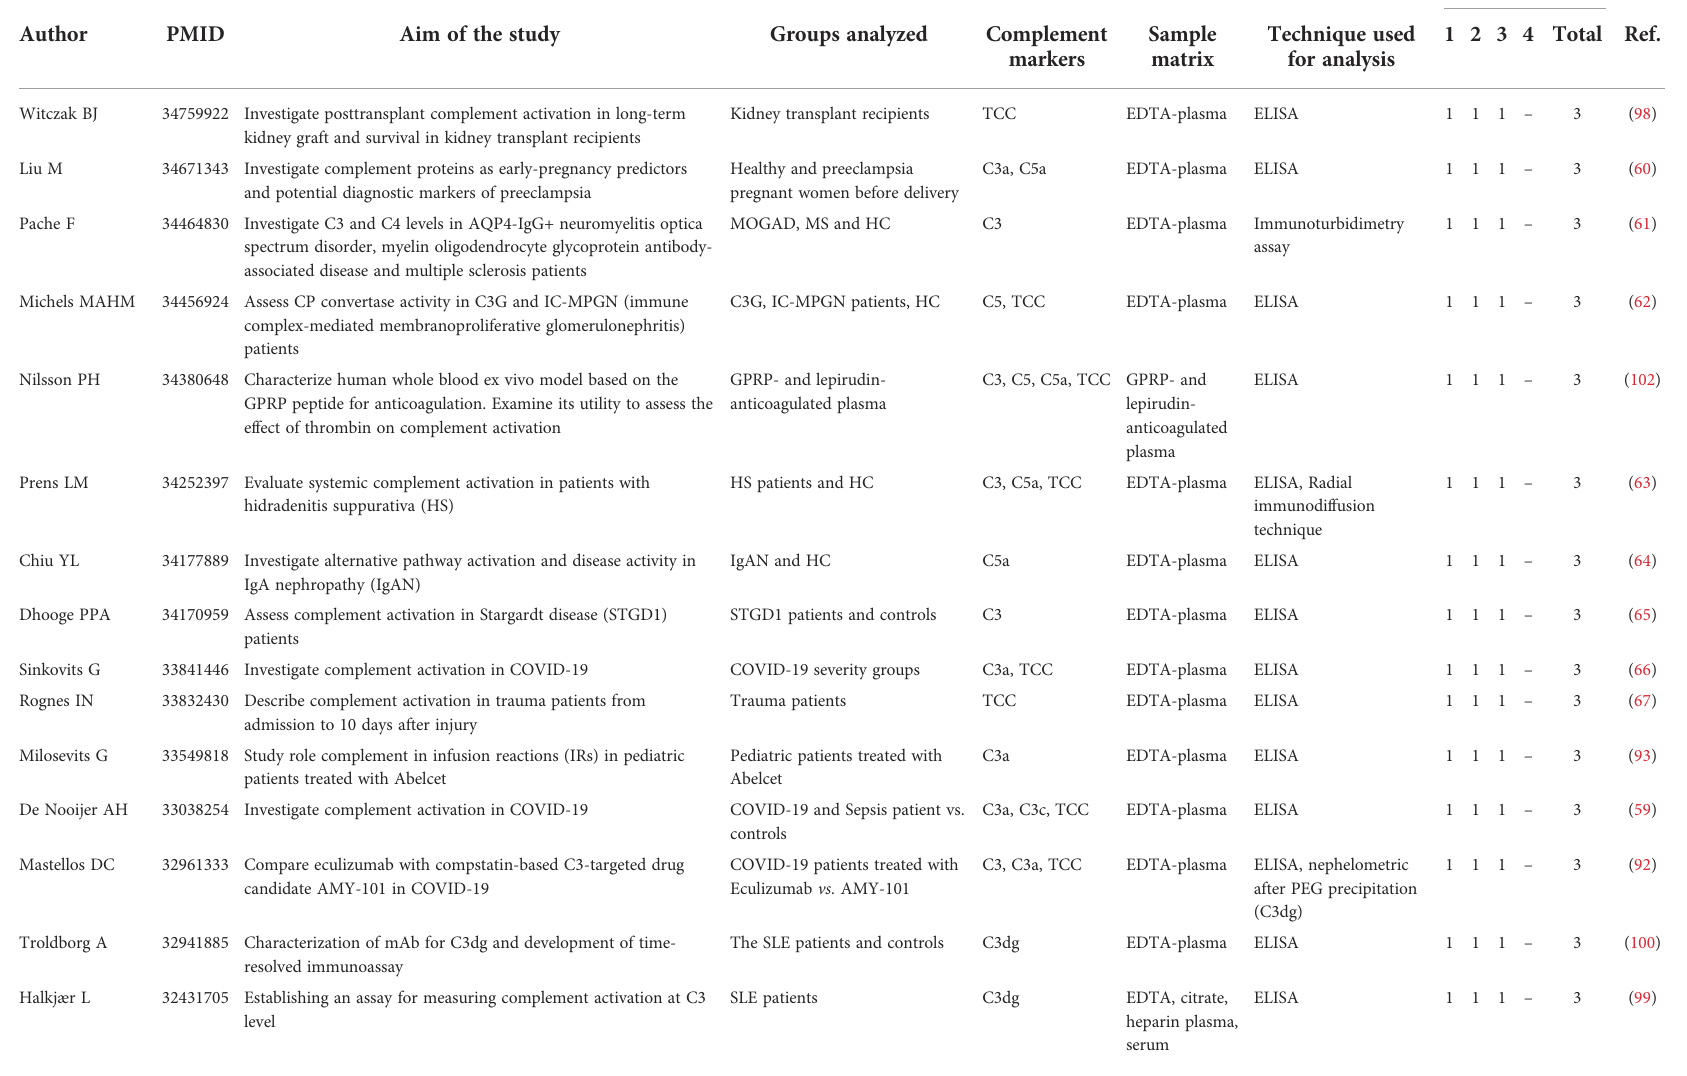
TABLE 2 Overview of the 45 selected studies that assessed complement components ex-vivo in the past 5 years